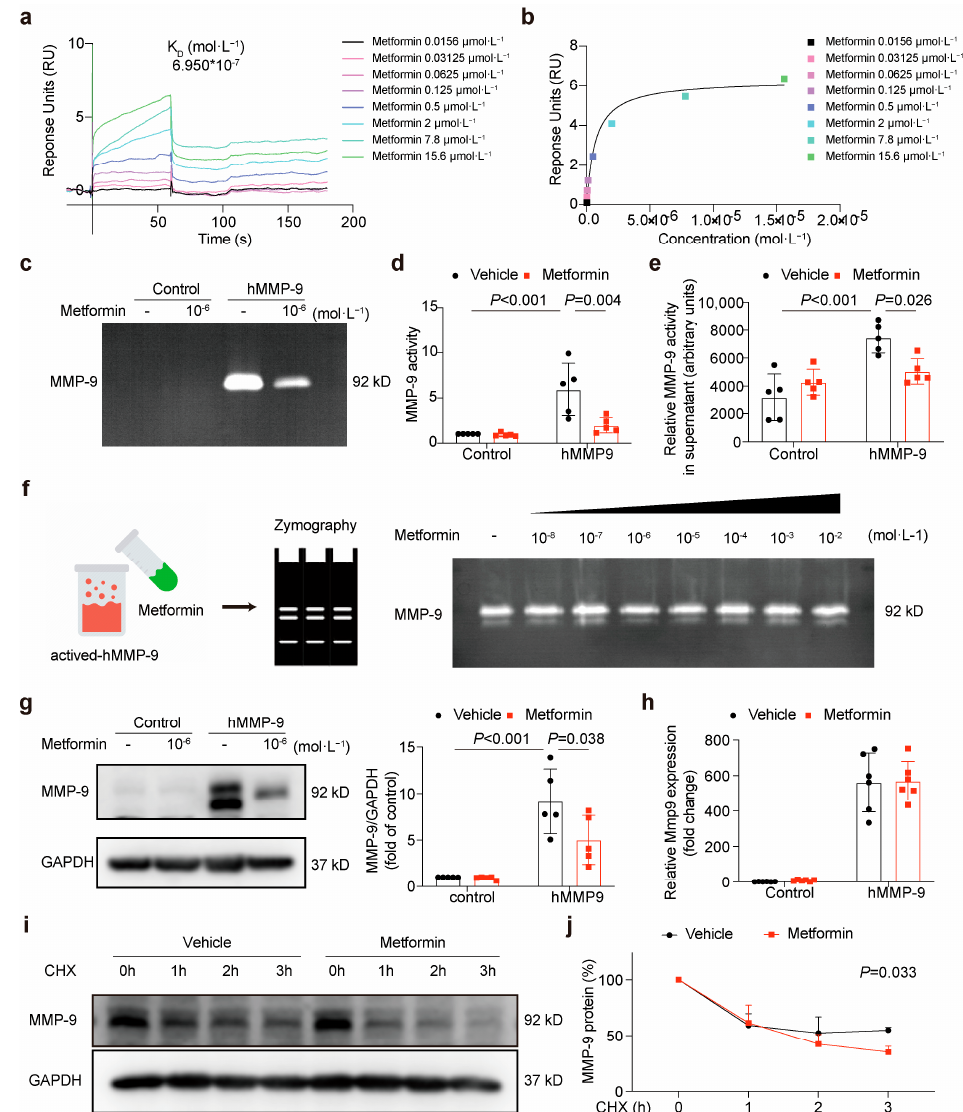
Figure 2. Metformin directly interacts with MMP-9 and attenuates its activity. ( a , b ) SPR analysis of the binding between metformin and MMP-9. Recombinant human MMP-9 protein was immobilized on an activated CM5 sensor chip, and metformin was then flowed across the chip. ( c , d ) Representative gelatin zymogram and the quantified values of the 92 kDa MMP-9 activity in the cultured supernatant. Data are shown as mean ± SD (two-way ANOVA followed by Tukey’s test, n = 5). ( e ) MMP activity in supernatant from cultured HEK293A cells was measured using a Gelatinase Assay Kit (two-way ANOVA followed by Tukey’s test, n = 5). ( f ) Representative gelatin zymogram of the recombinant human MMP-9 activity after incubation with different concentrations of metformin. ( g ) The exogenous MMP-9 protein level in HEK293A cells after incubation with metformin for 24 h (both of the 2 bands were quantified, two-way ANOVA followed by Tukey’s test, n = 5). ( h ) MMP-9 mRNA expression level in HEK293A cells after incubation with metformin for 24 h (n = 6). ( i , j ) Exogenous MMP-9 degradation in metformin-treated HEK293A cells when protein synthesis was inhibited by 10 µ M cycloheximide (two-way ANOVA followed by Tukey’s test, n =